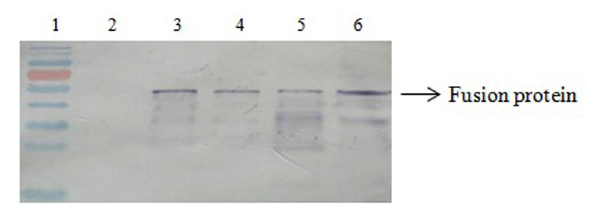
FIGURE 2 | Western blotting results. Lane 1, molecular markers; Lane 2, BMP-WT; Lane 3, BMP-CA; Lane4, fusion protein; Lane 5, BMP-FA; Lane 6, (cid:2) F-BMP-FA.